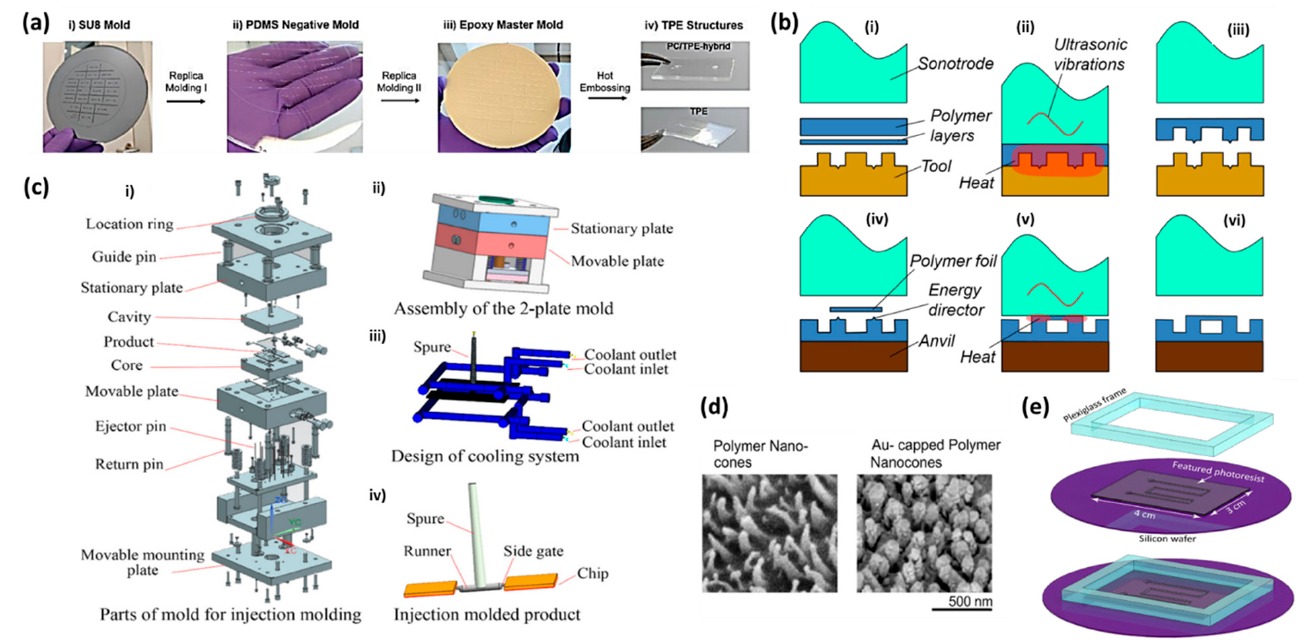
Figure 1. ( a ) Fabrication process of PC/TPE ‐ hybrid microchannels via hot embossing method. Reproduced with permission [31] 2022, MDPI. ( b ) ( i – iii ) Incorporation of ultrasonic vibration in hot embossing process to form PC microchannels ( iv – vi ) ultrasonic welding of PC layers. Reproduced with permission [33], 2022, Springer. ( c ) Injection mold design for fabrication of PMMA microfluidic devices. ( i ) Injection molding parts, ( ii ) Mold assembly, ( iii ) Cooling system, ( iv ) Final product. Reproduced with permission [45] 2022, Springer. ( d ) SEM images of nanocones made of COC through injection molding techniques. Reproduced with permission [48] 2022, ACS. ( e ) Silicon mold with photoresist patterns and plexiglass frame. The setup was used to cast PDMS master molds for hot embossing COC and creating microchannels. Reproduced with permission [26] 2022, Elsevier.